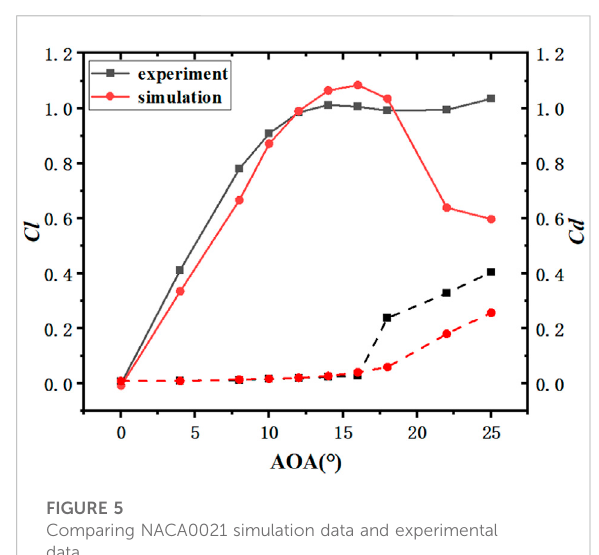
FIGURE 4 Lift-drag coef fi cient for different mesh quantities of the NACA0021 airfoil.